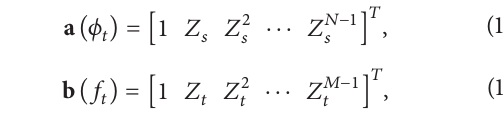
Figure 8: Range correlation of ionospheric clutter at − 1.2Hz.